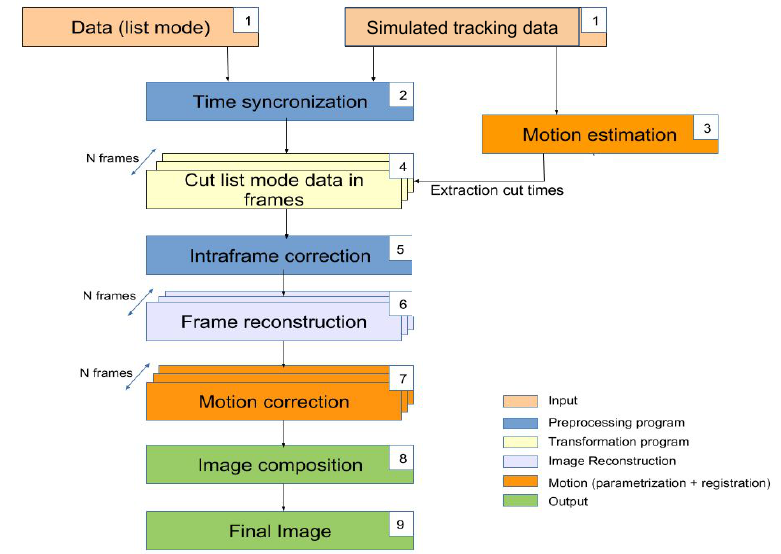
Figure 1. EMAF algorithm